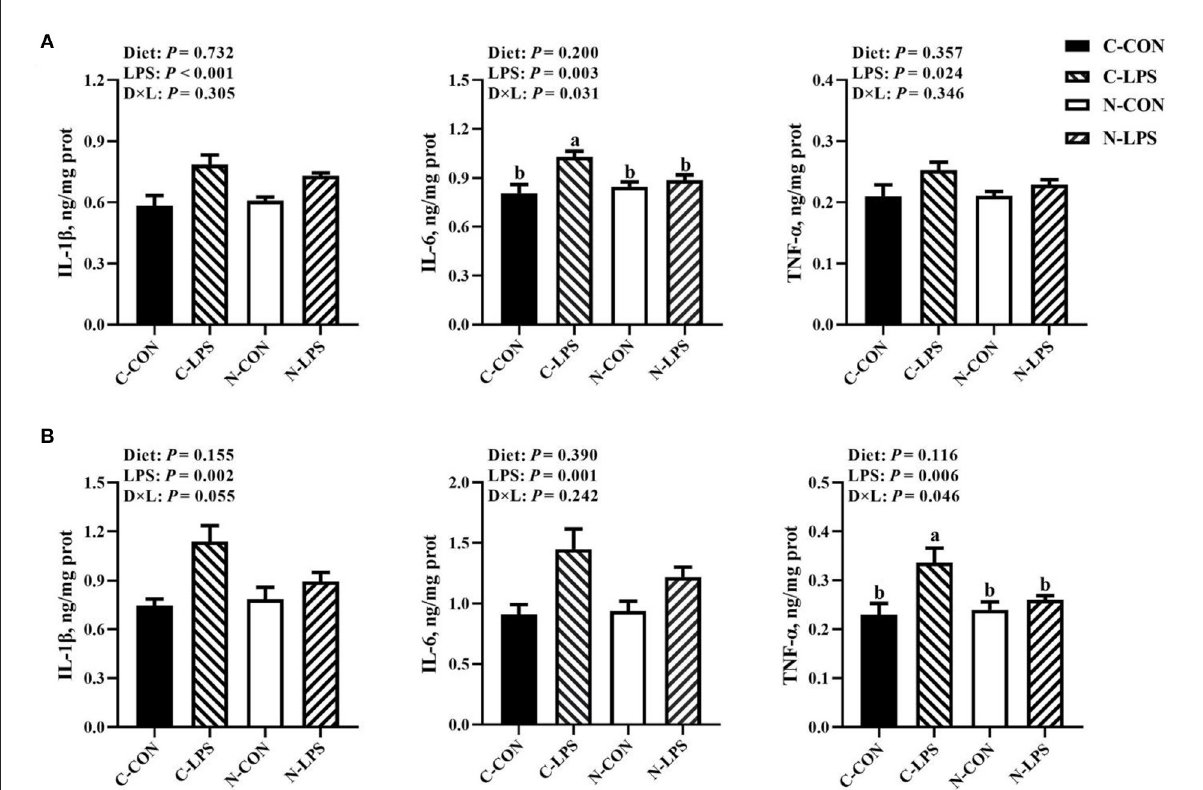
FIGURE2 Effects of maternal nucleotide supplementation on cytokine levels in jejunum and ileum in lipopolysaccharide-challenged newborn piglets. (A) Cytokine levels (IL-1 β , IL-6, TNF- α ) in jejunum. (B) Cytokine levels (IL-1 β , IL-6, TNF- α ) in ileum. Results were expressed as means with their standard errors, n = 6; a,b Means of the same parameter with different superscripts are significantly different ( P < 0.05). IL-1 β , interleukin-1 β ; IL-6, interleukin-6; TNF- α , tumor necrosis factor- α . C-CON, piglets were from the sows fed with basal diets and were challenged by sterile saline; C-LPS, piglets were from the sows fed with basal diets and were challenged by LPS; N-CON, piglets were from the sows fed with basal diets containing nucleotides and were challenged by sterile saline; N-LPS, piglets were from the sows fed with basal diets containing nucleotides and were challenged by